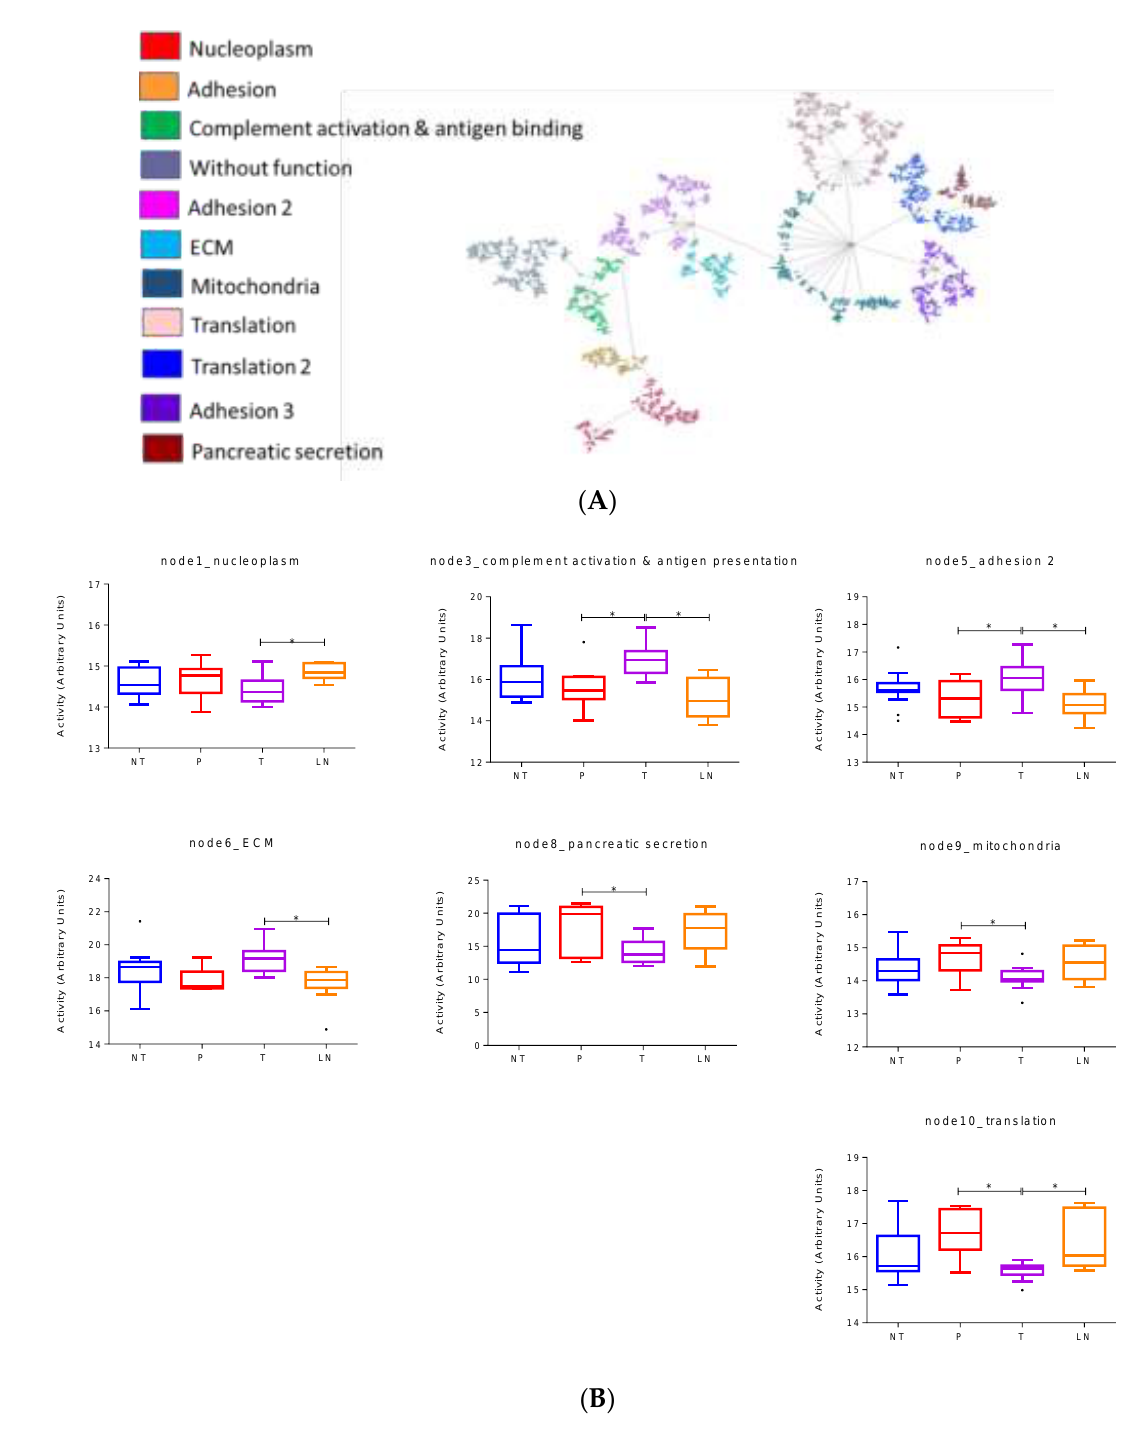
Figure 3. ( A ) Network of 2311 proteins in the T1 subtype. ( B ). Differential functional node activities comparing the different histological samples in the T1 subtype according to mixed linear models. NT = normal tissue, P = preneoplastic lesions, T = primary tumors, LN = lymph nodes. * p < Table 2. Summary of functional node activities identified as differential using mixed linear models between samples in each PDAC proteomics subtype. NT = no tumor tissue, P = preneoplastic lesions, T = primary tumor, LN = lymph node metastasis.